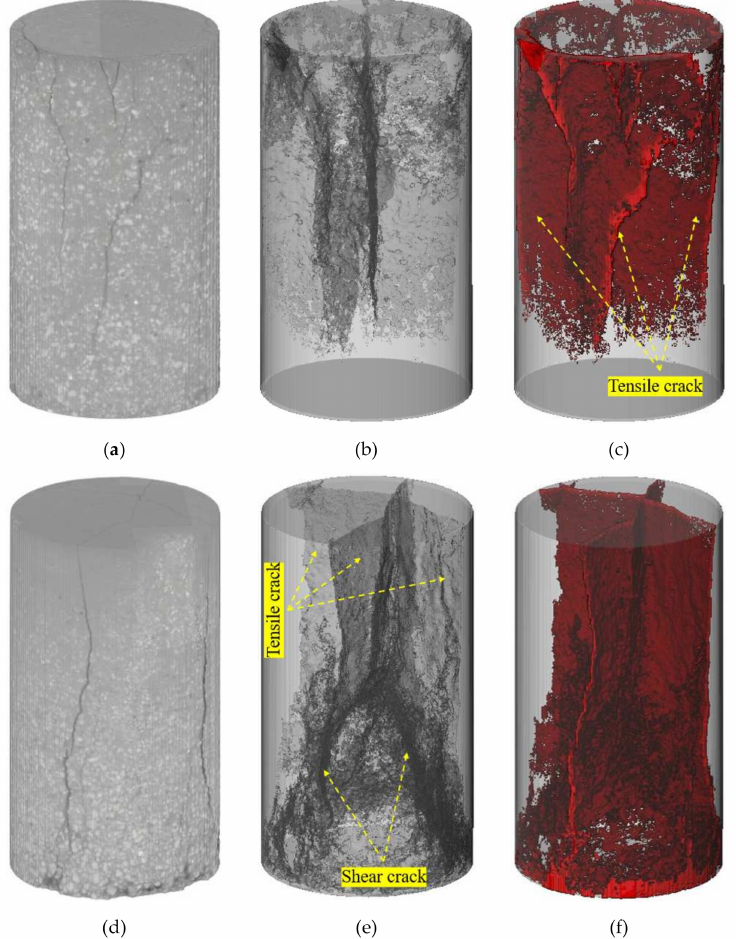
Figure 8. The failure modes of CBC samples. ( a – c ) Gypsum: 10 wt. %, FA: 50 wt. % and SS: 40 wt. %; ( d – f ) Gypsum: 10 wt. %, FA: 40 wt. % and SS: 50 wt.